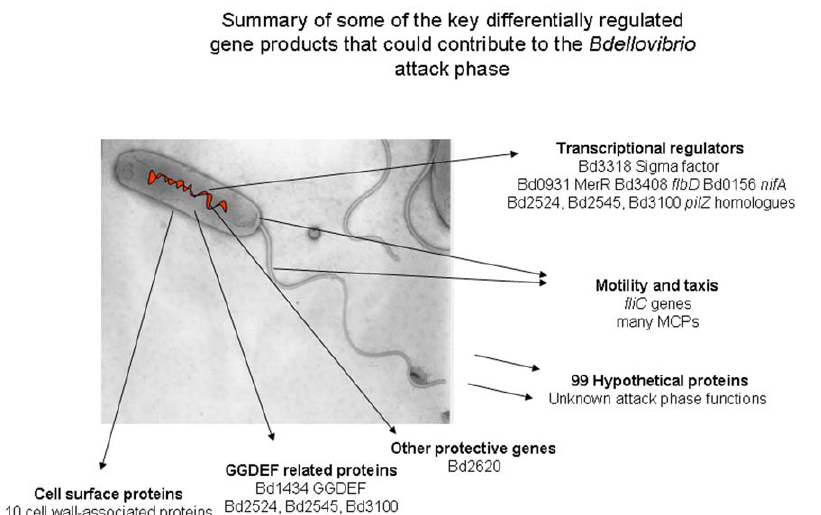
Figure 7. Gene expression key to attack phase. Visual summaries of key gene expression characteristics of the attack phase of Bdellovibrio cells, as implied by genes highly expressed In the attack phase dataset, but downregulated in the other two datasets.